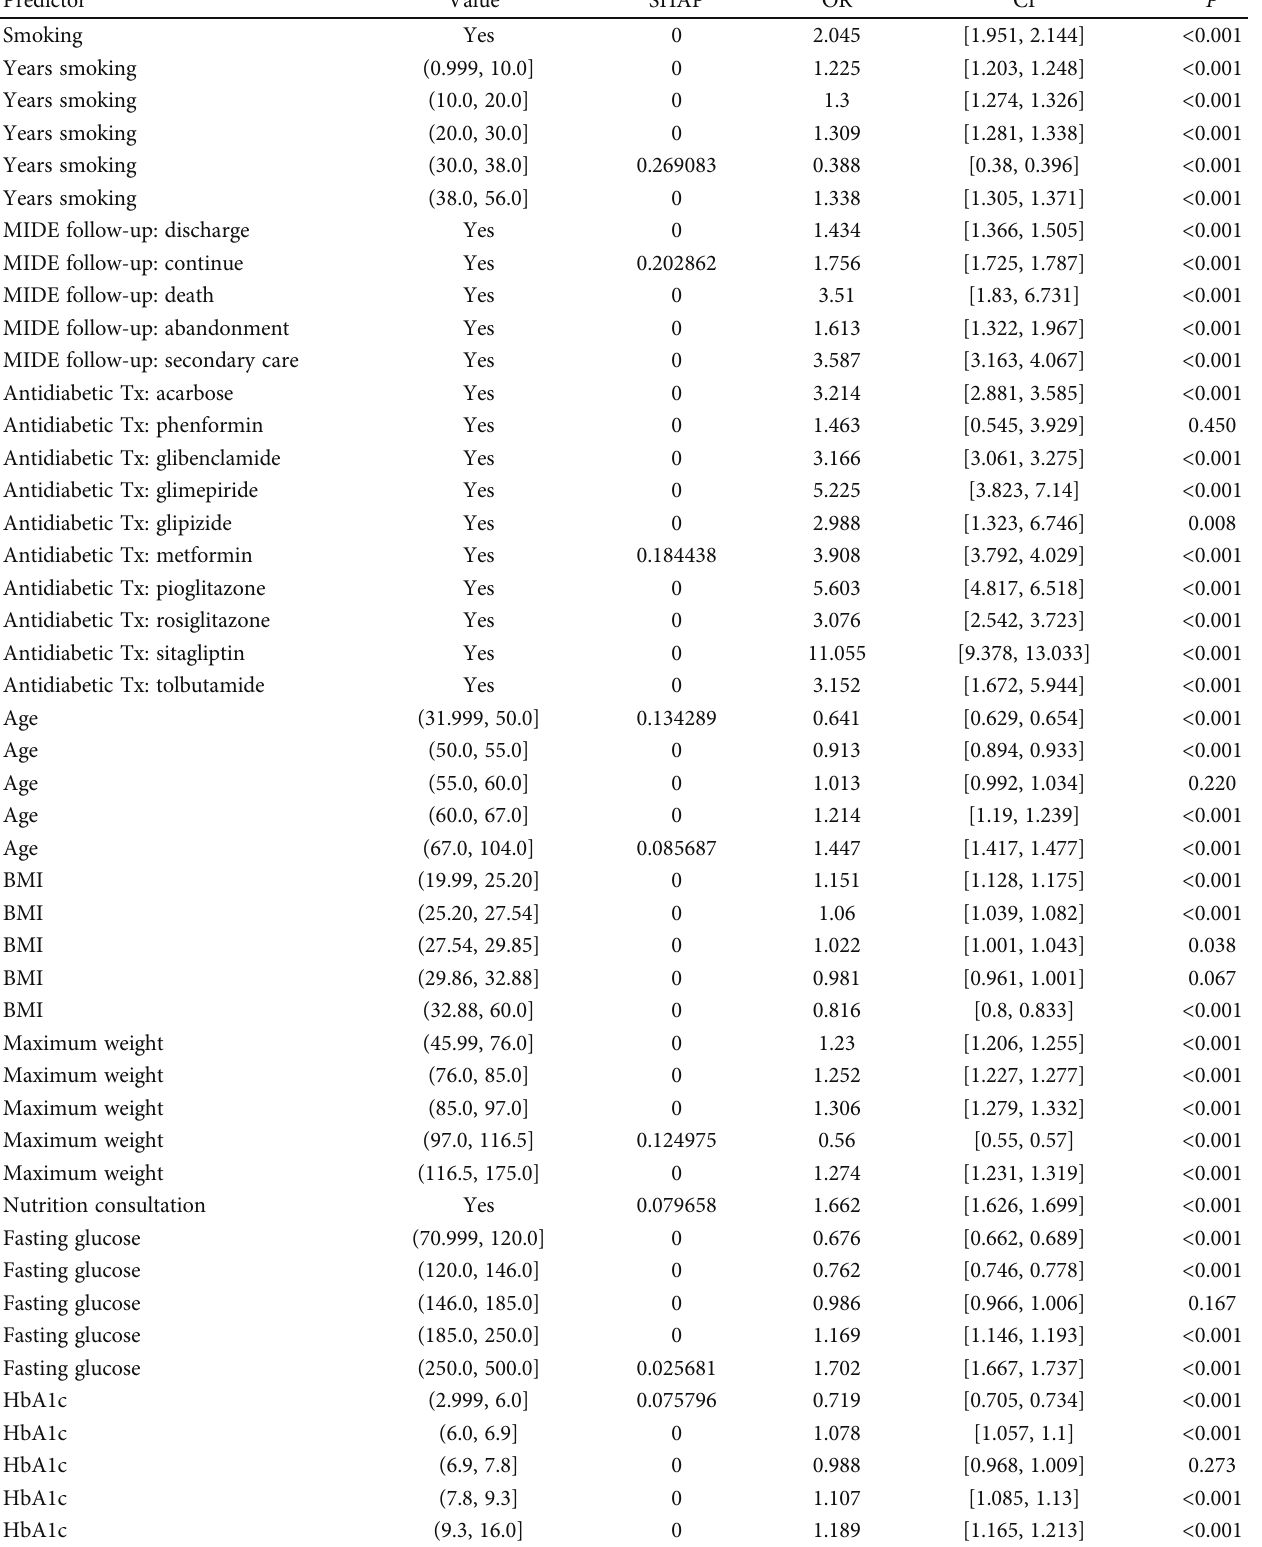
Table 3: In-depth analysis of the predictors for the model of chronic complications in patients with diabetes.